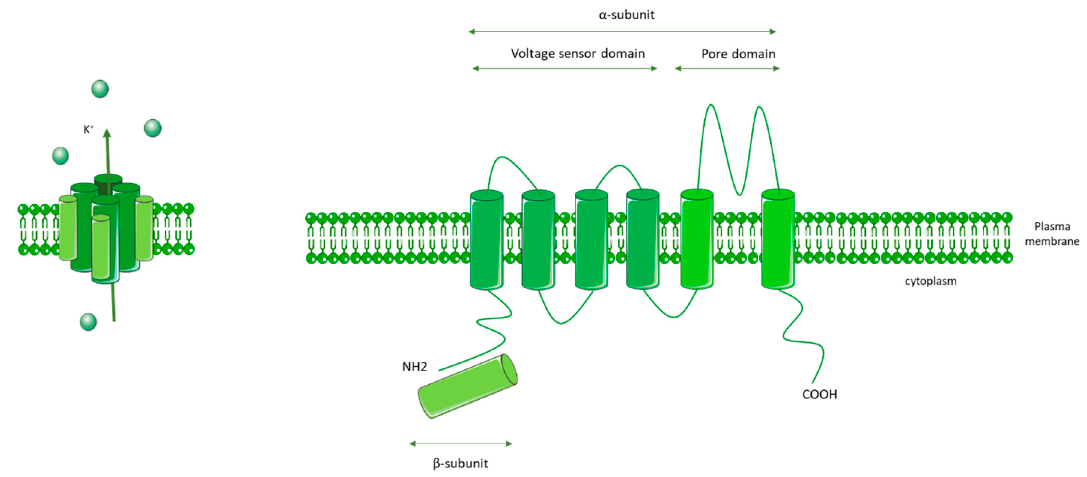
Figure 6. General molecular architecture of voltage-gated K + channels (Kv channels). Kv channels are comprised of a voltage sensor domain (VSD), which detects changes in the transmembrane voltage, and a pore domain (PD). The VSD and PD are comprised of six transmembrane domains. Kv channels are also comprised of a β subunit. Kv channels form as homo- or heterotetramers composed of four α subunits and four β subunits.